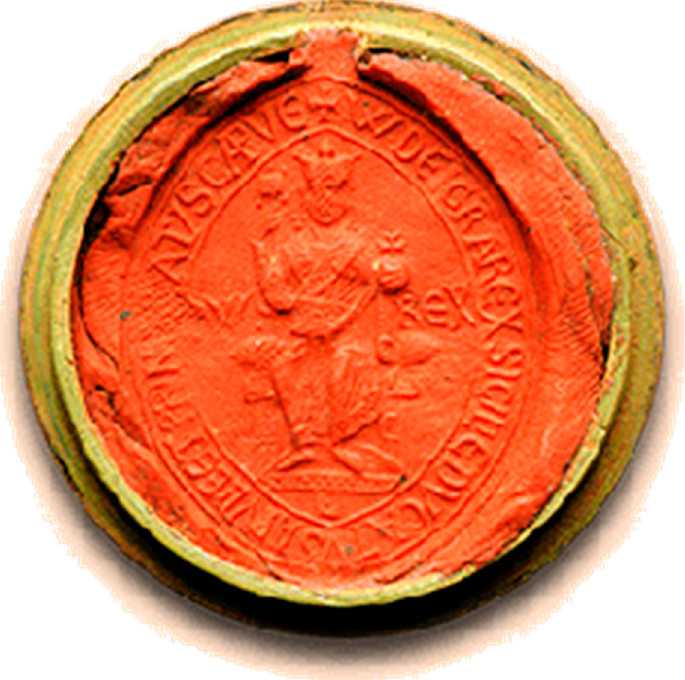
Figure 2. Seal of William II of Hauteville, impression on red wax, 15 April 1172. Palermo, Archivio Storico Diocesano, Tabulario della Cattedrale, diploma n. 22. Image published in: [3] (Figure 6).